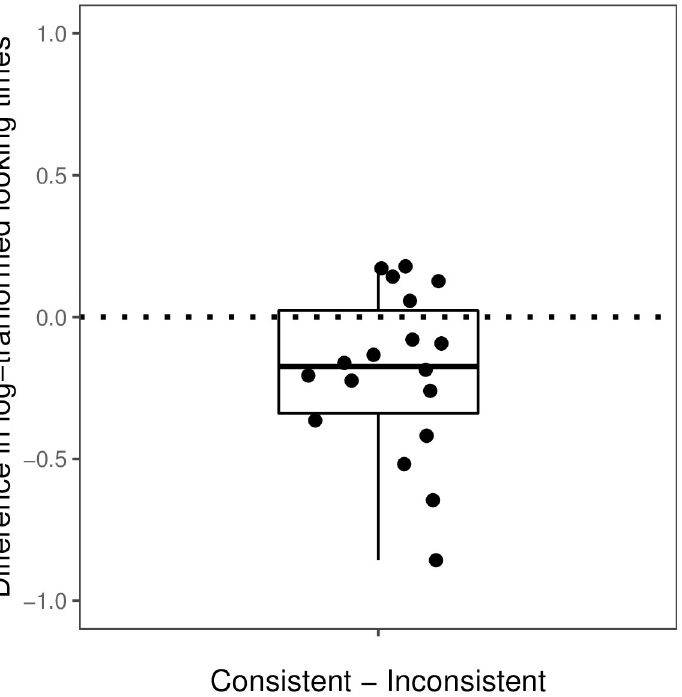
Fig 5. By-subject mean difference in log-transformed looking times between consistent and inconsistent test trials in Experiment 2.